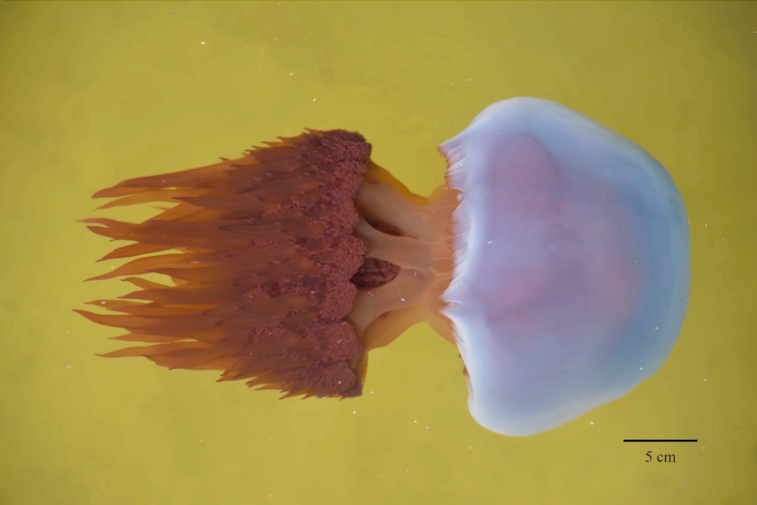
Picture of the jellyfish R. esculentum captured in Yingkou, Liaoning Province, China.